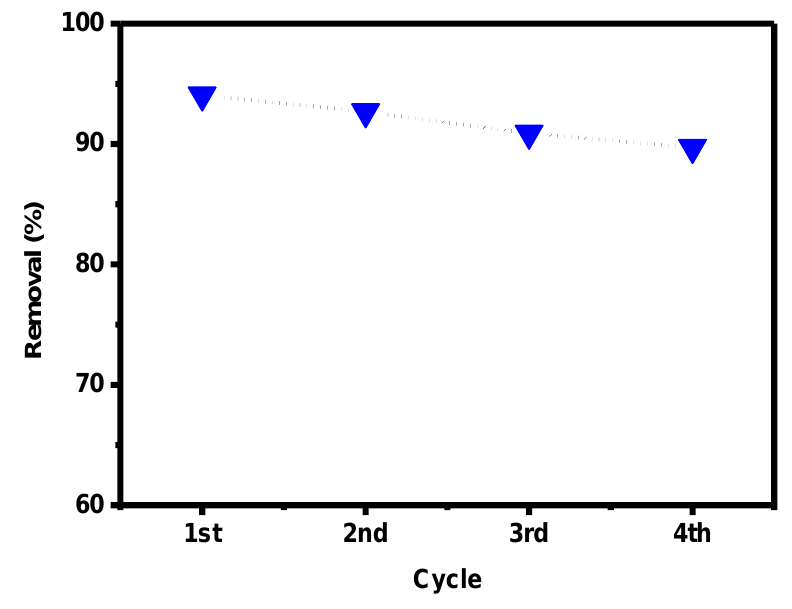
Figure 13. Recycling effect of GO-date Seeds.